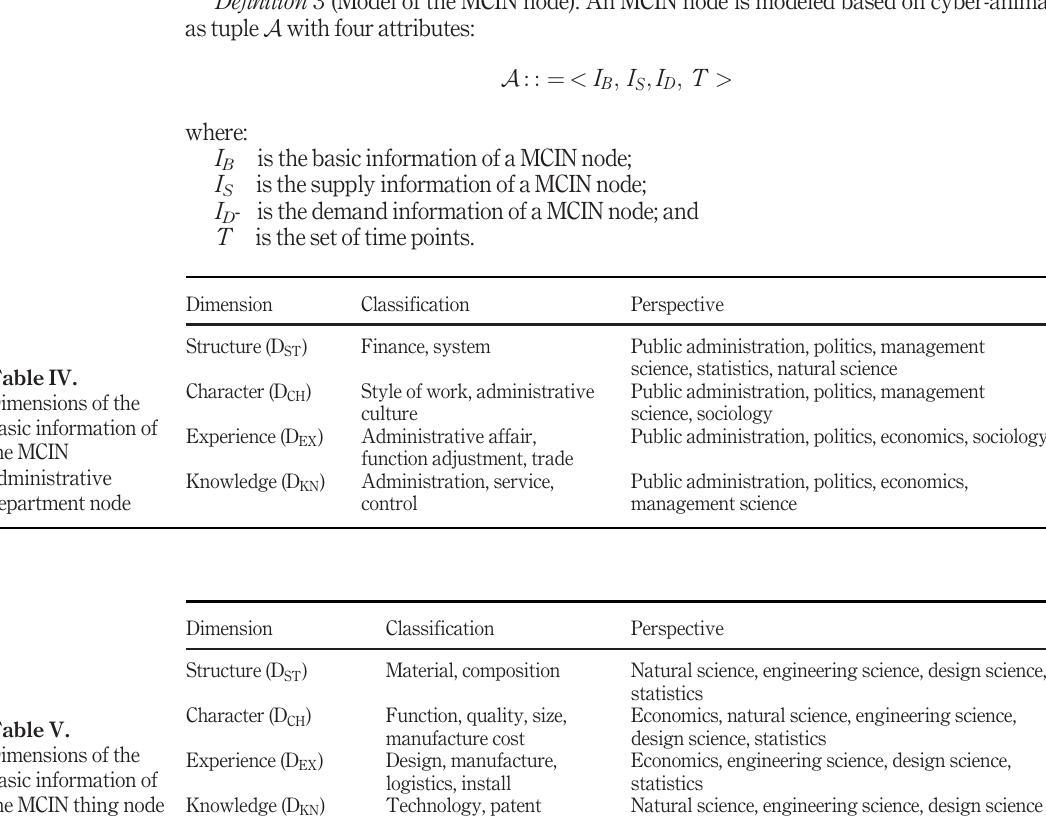
Table V. Dimensions of the basic information of the MCIN thing